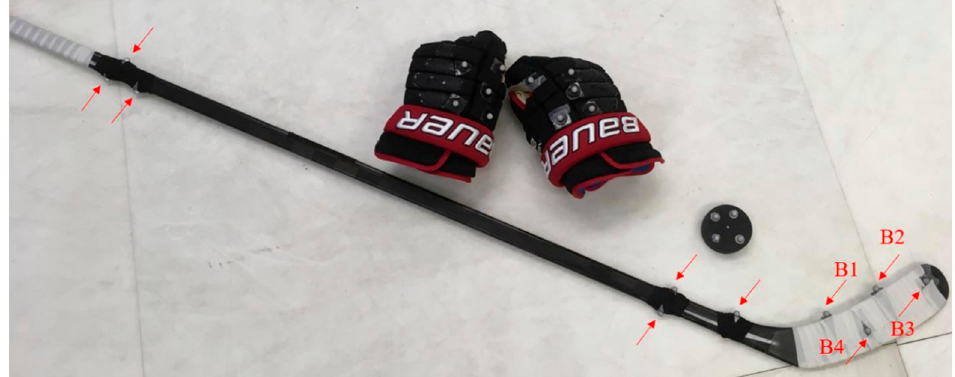
Figure 2. Reflective marker placement on gloves, stick, and puck for tracking by the Vicon system. B1–4 indicate markers used to define the movement of the stick blade during the shooting trials.